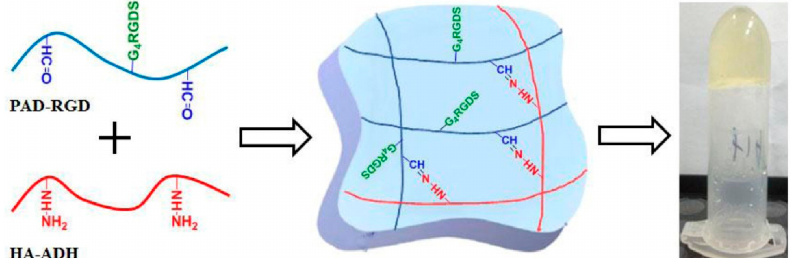
Figure 3. Hydrogels synthetic scheme [42]. Reproduced with permission from Elsevier, 2017.